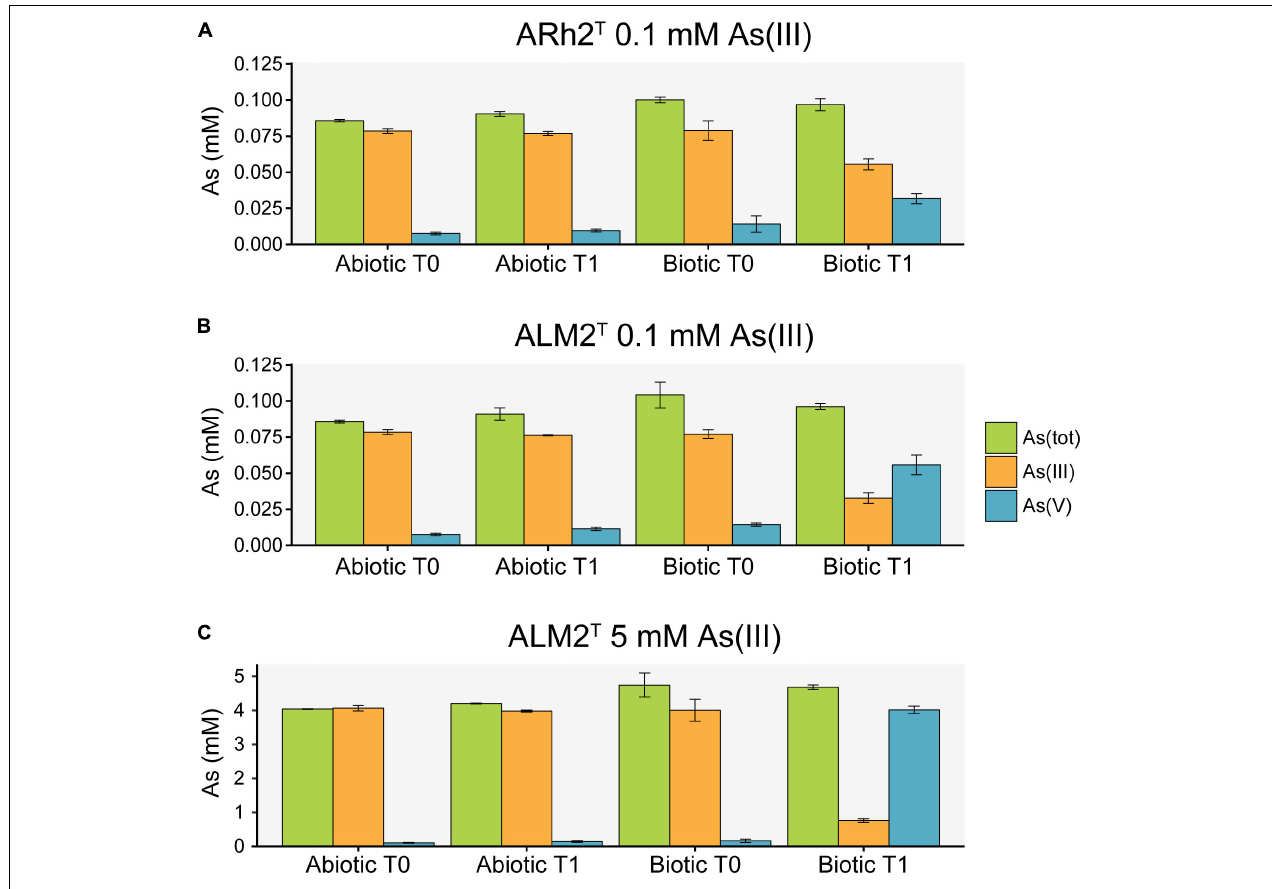
FIGURE 2 | Arsenic species analysis of culture fluid from sterile samples (Abiotic) and samples inoculated with Tv. thiocyanoxidans ARh2 T and Tv. jannaschii ALM2 T (Biotic) at the inoculation (T0) and sampling time (T1). (A) ARh2 T culture incubated with 0.1 mM As(III) for 2 days. (B) ALM2 T culture incubated with 0.1 mM As(III) for 1 day. (C) ALM2 T culture incubated with 5 mM As(III) for 5